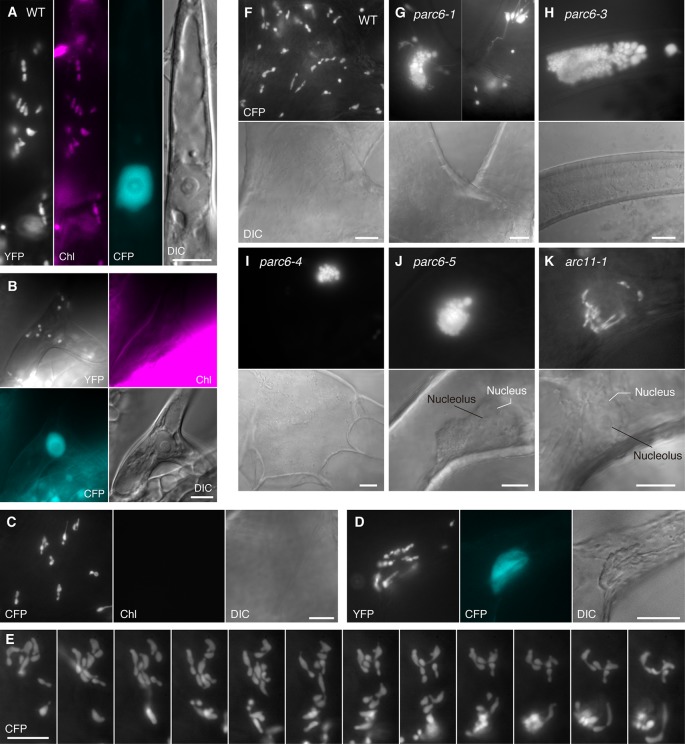
Morphology of plastids in leaf trichome cells of parc6 and arc11 mutants. (A–K) Images of trichomes in leaf petioles of WT (A–F), parc6-1
(G), parc6-3
(H), parc6-4
(I), parc6-5
(J), and arc11-1
(K) seedlings. The 3rd and 4th leaves of 2-week-old seedlings were mainly observed (A–C, F–K). Images of stroma-targeted CFP or YFP (black-and-white), chlorophyll autofluorescence (magenta) (A–C), nucleus-targeted CFP (cyan) (A, B, D), or DIC are shown. Time-lapse observation was performed for 5 min in (E). Scale bar = 10 µm.